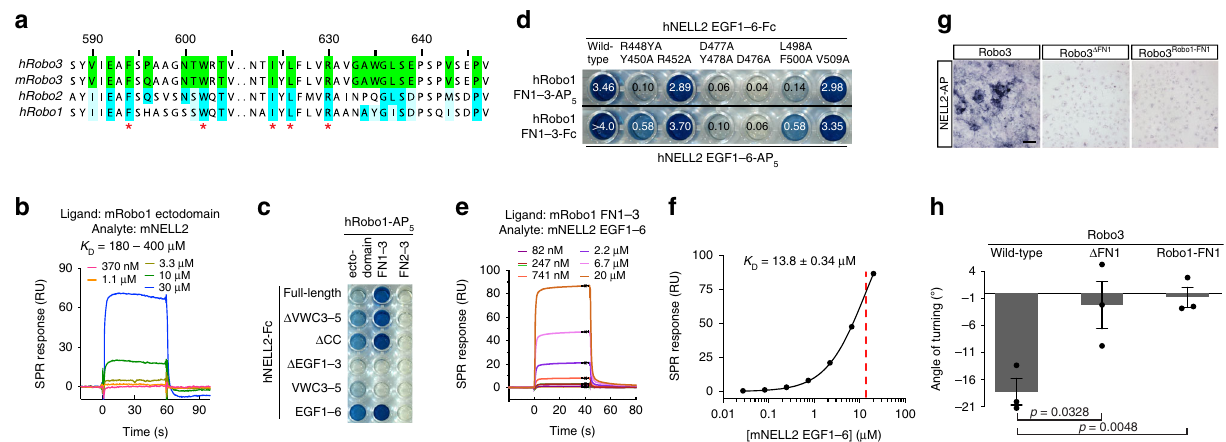
Fig. 6 Robo1 interacts weakly with NELL2. a Partial alignment of Robo FN1 sequences. Green squares indicate Robo3 residues at the NELL2-binding interface. Blue positions are identical in Robo1 and Robo2, while light blue represents conservative substitutions. b Surface plasmon resonance sensorgrams for the mRobo1 ectodomain-mNELL2 interaction. Expected maximal response is ~1,100 RU. c ECIA results for hRobo1 and hNELL2 show that FN1 and the EGF1 – 3 are necessary for the interaction. See Supplementary Fig. 6a for expression levels of each construct used. d ECIA results for Robo1 binding to NELL2 mutants designed at the Robo3-interaction interface. Comparison with Robo3 binding to NELL2 mutants in Supplementary Fig. 3c shows that Robo1 binding has the same binding surface on NELL2 with similar energetics of binding. Expression levels of ECIA constructs are measured with western blotting in Supplementary Fig. 6b. e Surface plasmon resonance sensorgrams for the mRobo1 FN1 – 3-mNELL2 EGF1 – 6 interaction. f Langmuir binding isotherm for ( e ). Dashed red line indicate the dissociation constant, K D . Calculated R max is 143 R.U. The fi t to the isotherm is reliable given a theoretical R max of 218 R.U. assuming a 100% active chip surface. g NELL2-AP-binding assay with cells expressing Robo3.1, Robo3 Δ FN1 , or Robo3 Robo1-FN1 . h Quanti fi cation of turning angles in response to NELL2 for Robo3 − / − commissural axons rescued with wild-type Robo3.1, Robo3 Δ FN1 , or Robo3 Robo1-FN1 ( n = 3 for all conditions). Scale bar, 100 μ m ( g ). Error bars indicate